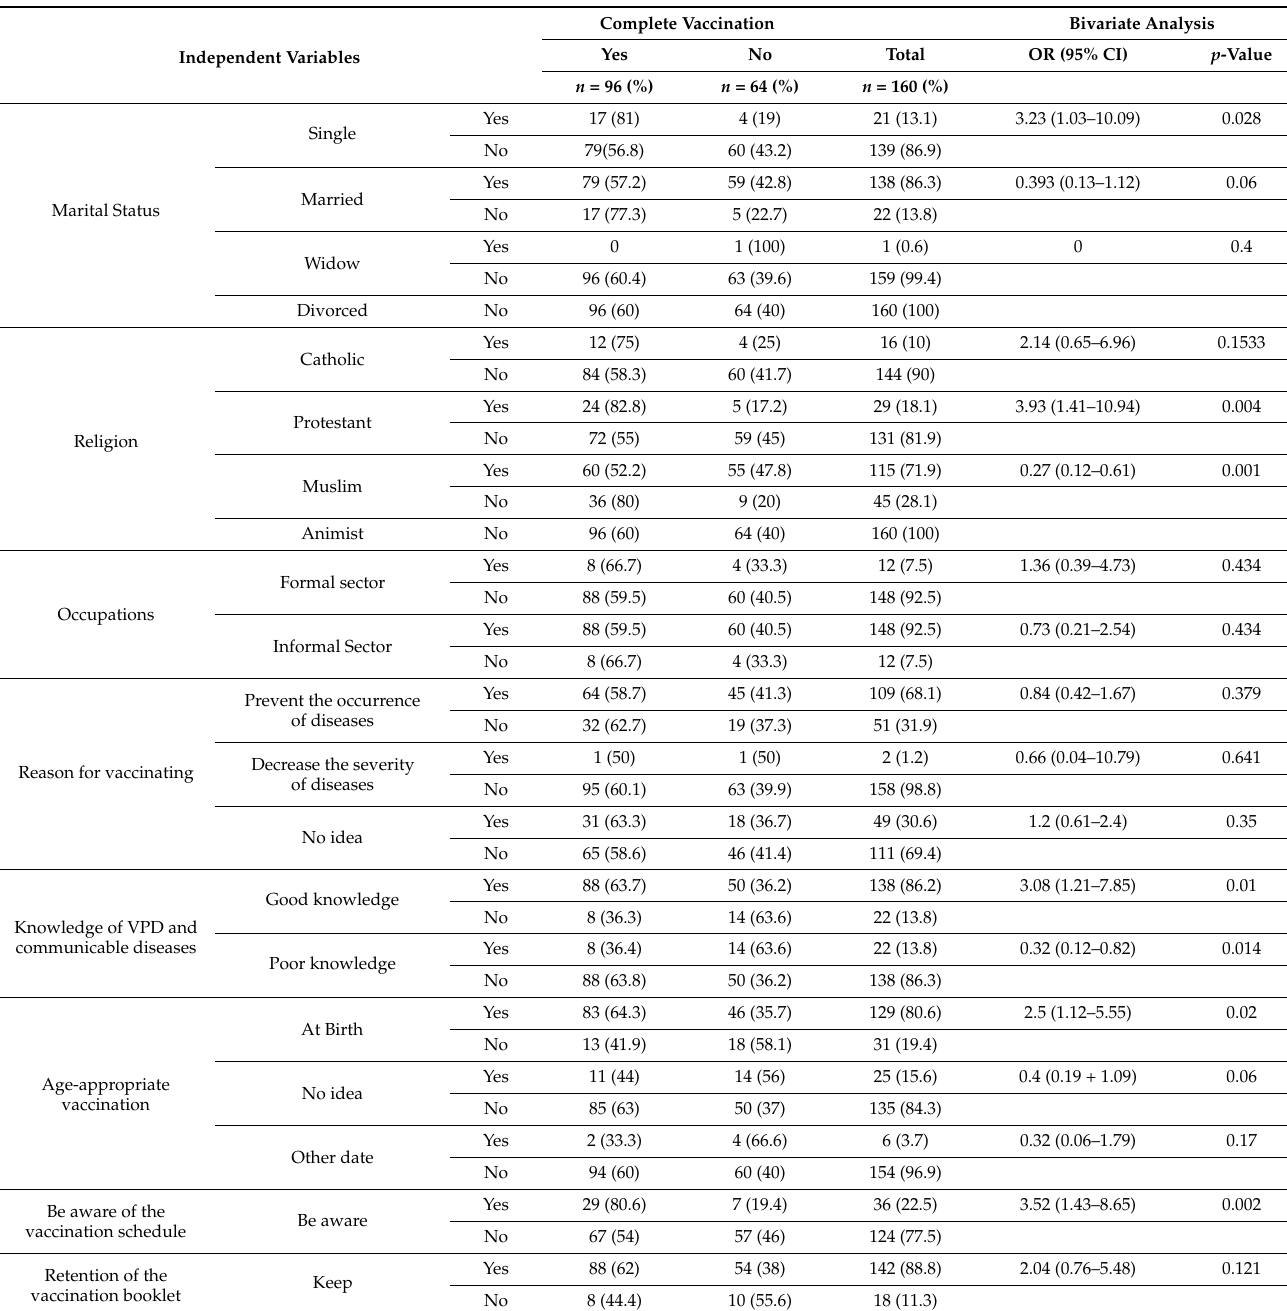
Table 4 present the results of the stepwise method based on forward selection to purposely assess the contribution of each independent variable towards the prediction of complete childhood vaccination. The effect of the variables (religion, age-appropriate vaccination, knowledge of VPDs) was statistically significant (that is with Sig. < 0.05). This means that the variables found in Table 4 contribute significantly to the explanatory power of parents’ decision to complete vaccination. However, the following variables (marital status and being aware of the vaccination schedule) were dropped from the final model with the stepwise method of forward selection since they did not contribute towards the prediction of complete vaccination in Supplementary